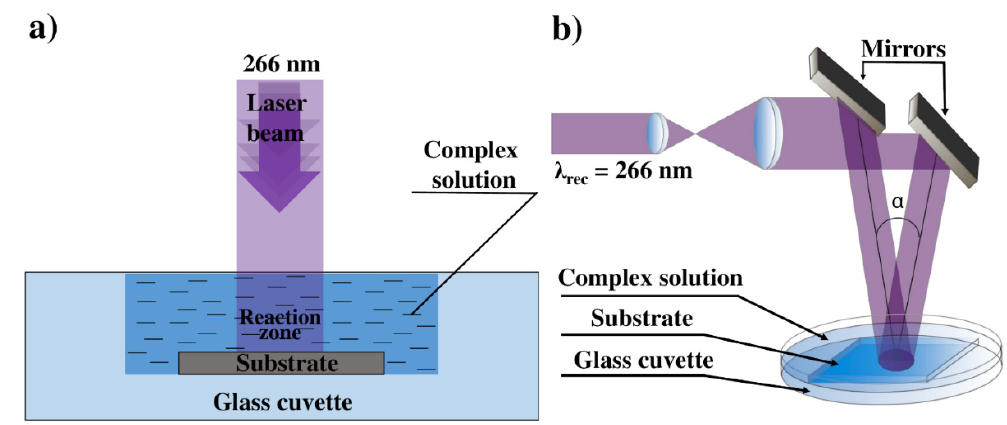
Figure 1. ( a ) Reaction system of LID; ( b ) Experimental setup for synthesis of periodic silver nanoparticle structures using holographic recording.